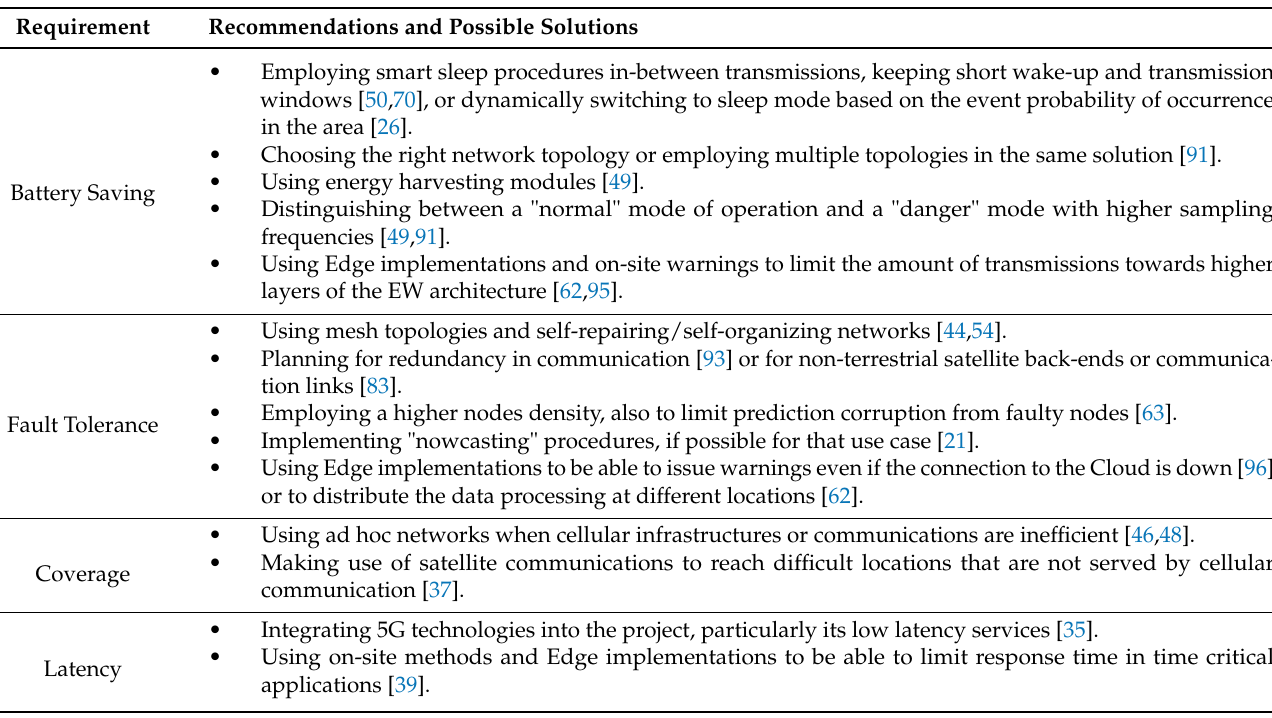
Table 9. Recommended solutions for each of the main EW